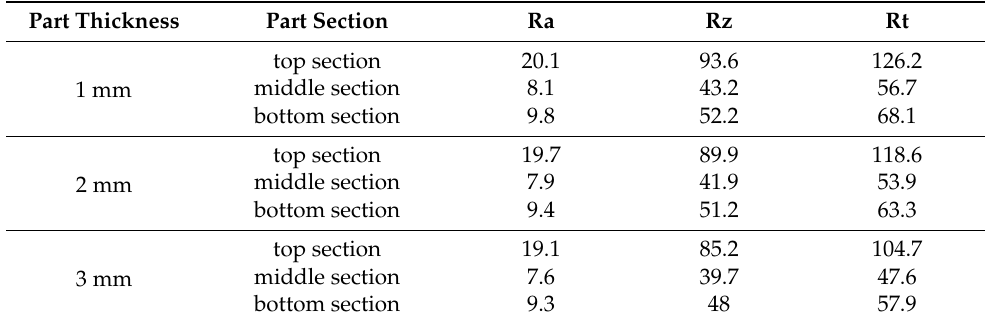
Table 1. Surface roughness of parts printed in orientation